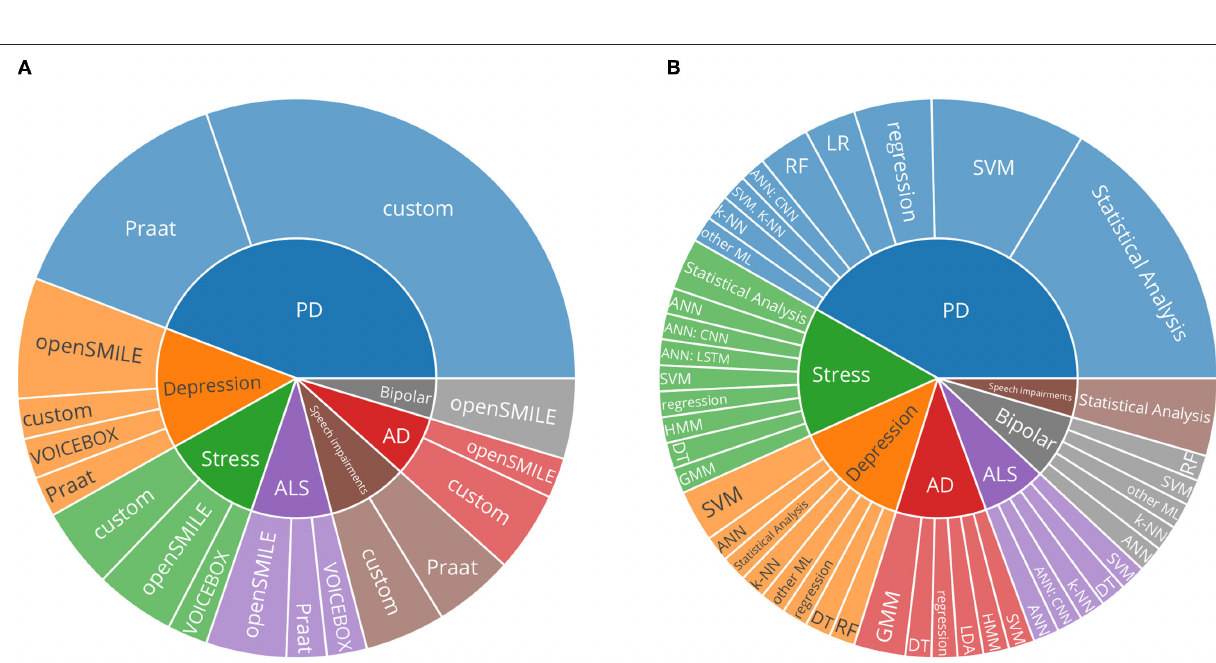
Frontiers in Digital Health |